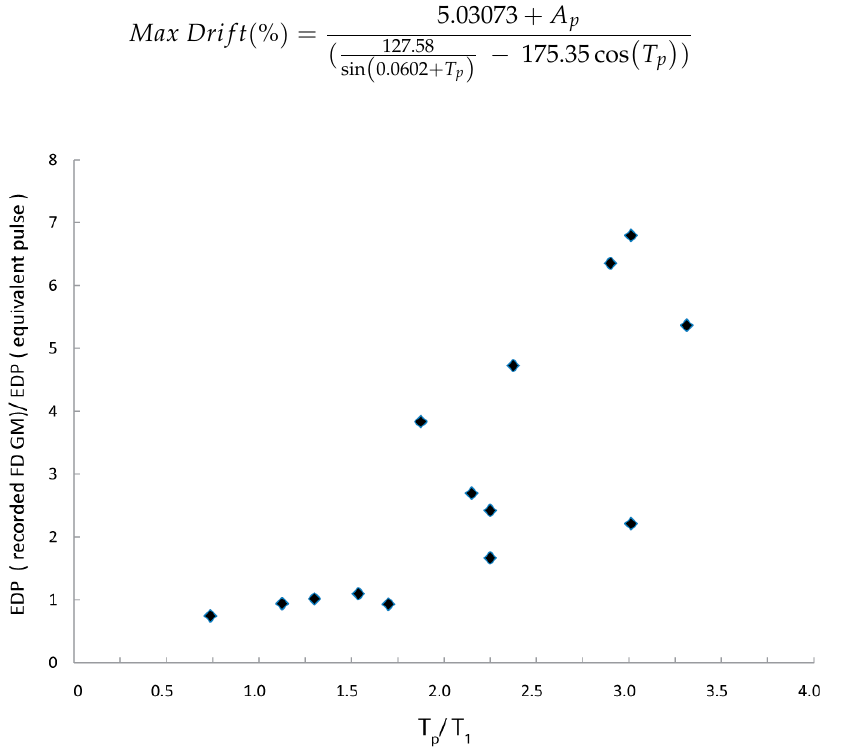
Figure 9. Plot showing the ratios of EDP computed for recorded ground motions to those computed using equivalent pulses, plotted against T p / T .